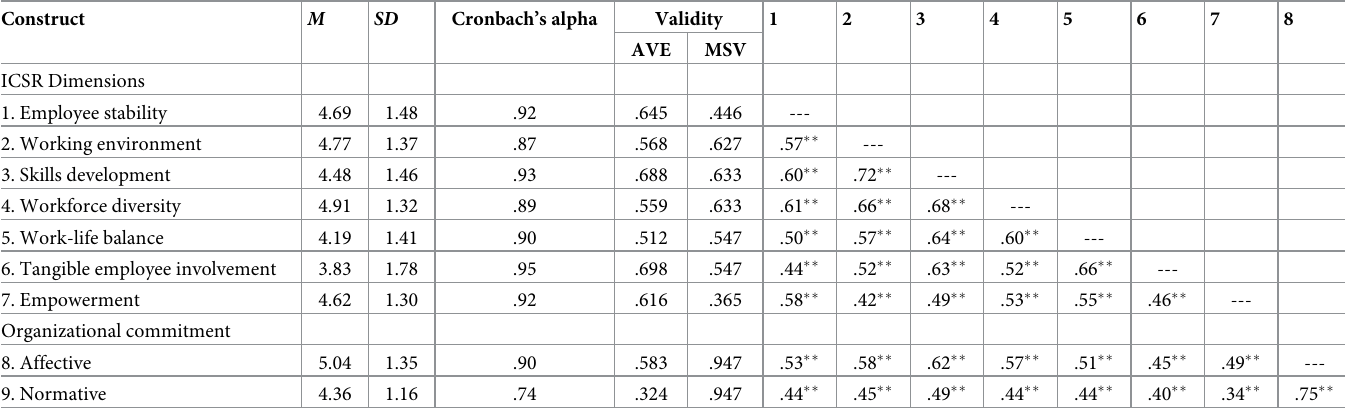
Table 1. Means, standard deviations, reliability and intercorrelations among study variables.